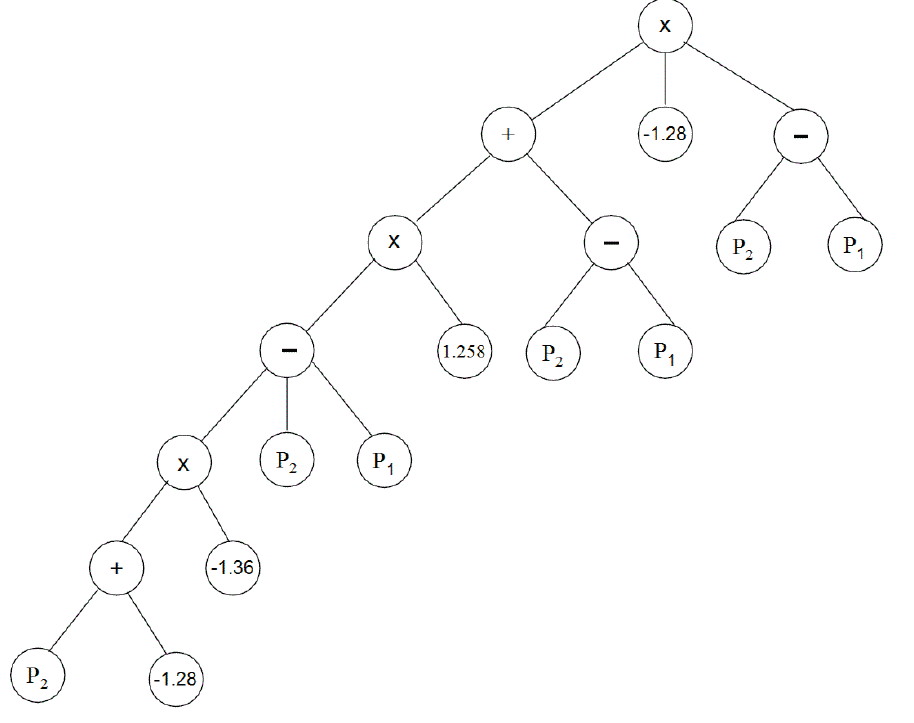
Table 5. The simplified equations derived by GP for the downscaling of extreme rainfall indices (descriptions of P